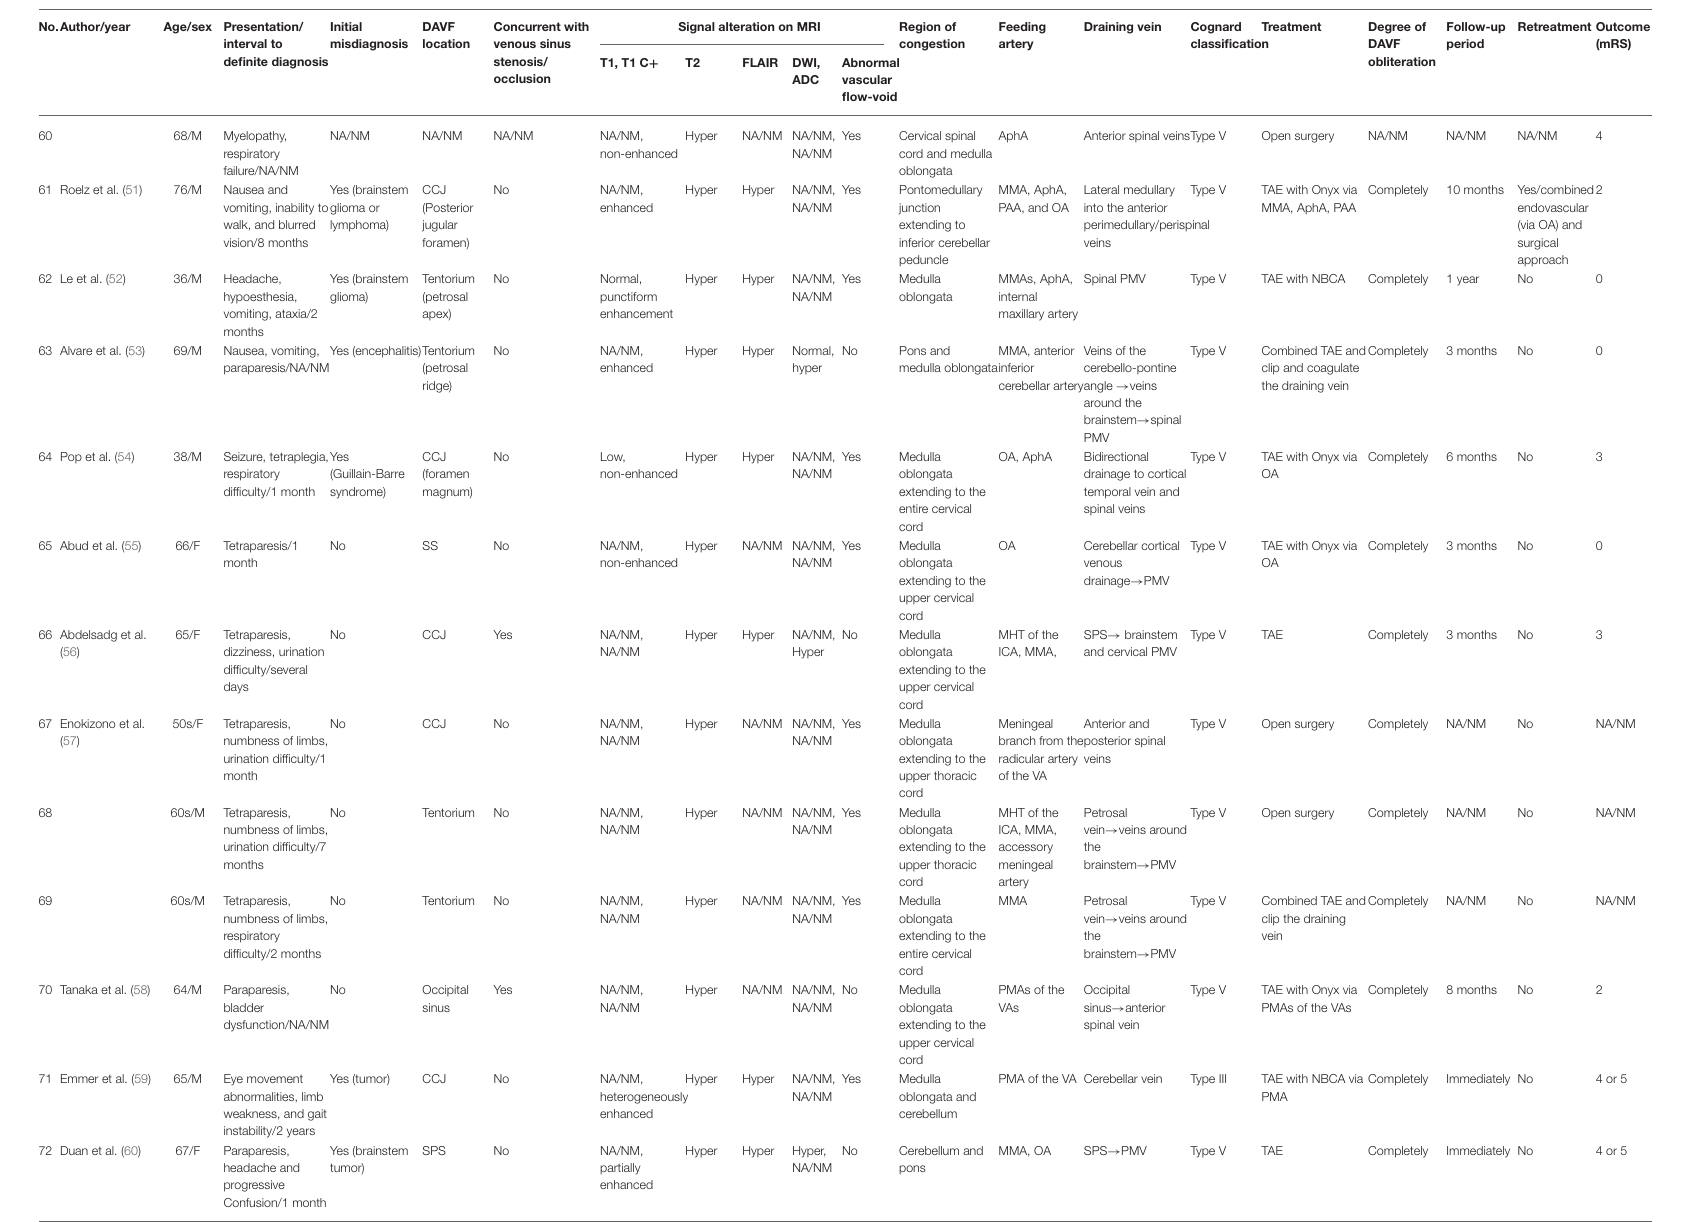
extendingtothe uppercervical cord